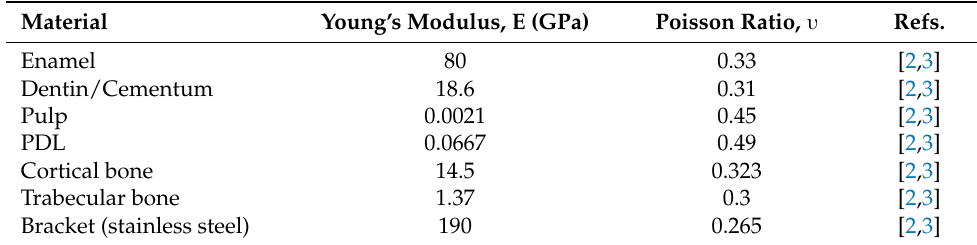
Table 1. Elastic properties of materials